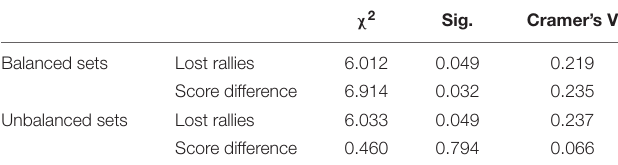
TABLE 2 | Model of binary logistic regression analysis in balanced sets. TABLE 1 | Association of the independent variables with the dependent variable. χ 2 Sig.